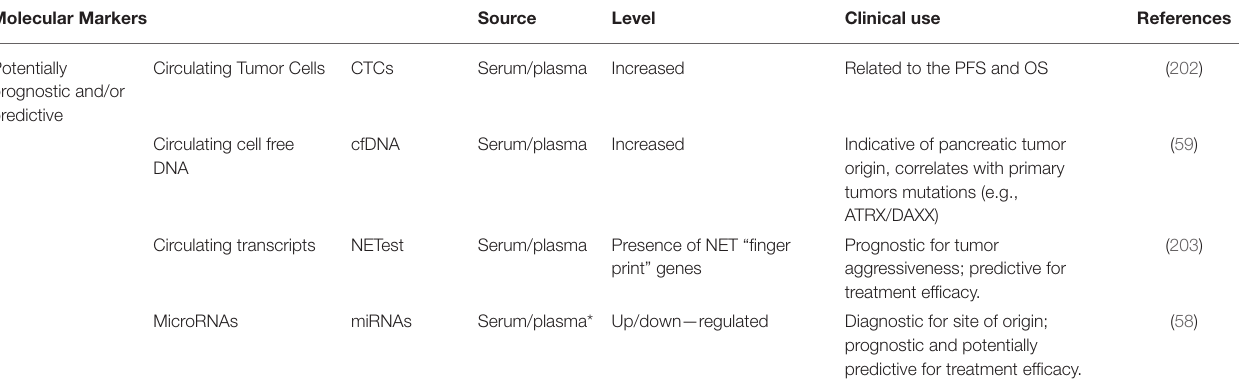
TABLE 4 | Circulating and tissue molecular biomarkers for PanNENs diagnosis, prognosis and treatment monitoring. Molecular